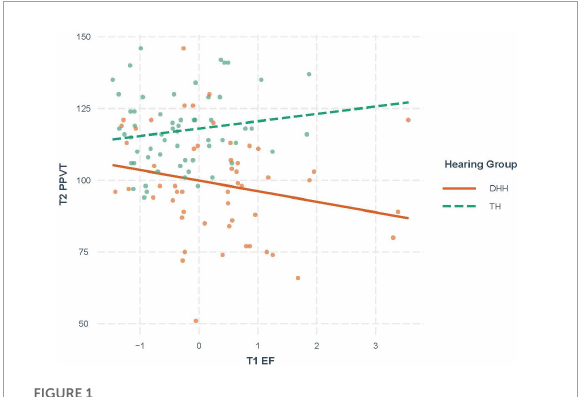
FIGURE1 Interaction between TH and DHH children for the association of T1 EF and T2 PPVT. Children who are DHH demonstrate a marginally significant negative longitudinal association while the TH children do not show a significant association. T1, timepoint 1; T2, timepoint 2 10–14 months after T1; PPVT , Peabody Picture Vocabulary Test–Fourth Edition (standard scores); EF, executive functioning score; TH, typical hearing; DHH, deaf or hard-of-hearing.